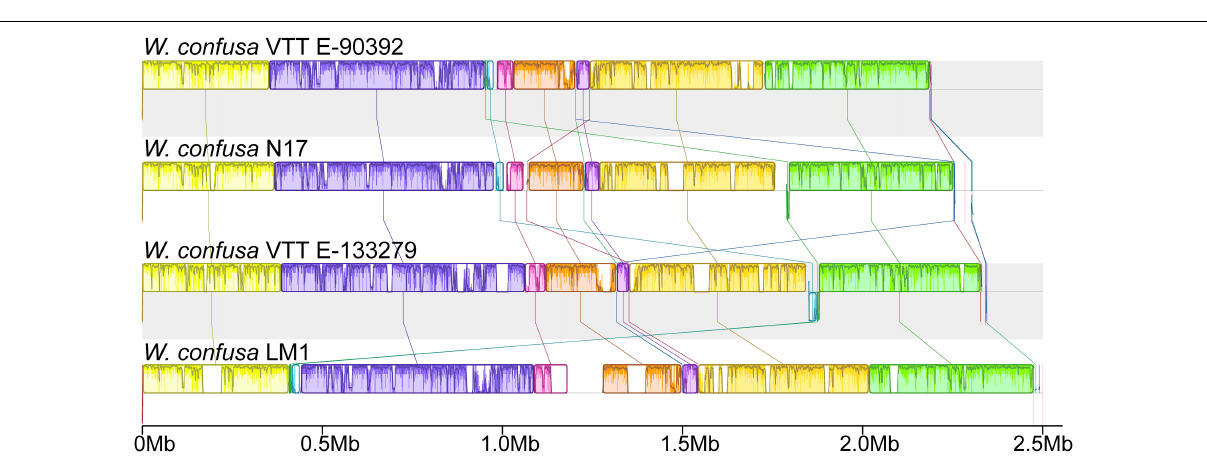
FIGURE 4 | Complete genome alignment of W. confusa strains. MAUVE alignment of the genome sequences of W. confusa VTTE-90392, W. confusa N17, W. confusa VTTE-133279, and W. confusa LM1. Boxes in the same color represent homologous regions [local colinear blocks (LCBs)] between W. confusa genomes. Uncolored regions within the LCBs or in-between LCBs indicate the presence of specific sequences in this